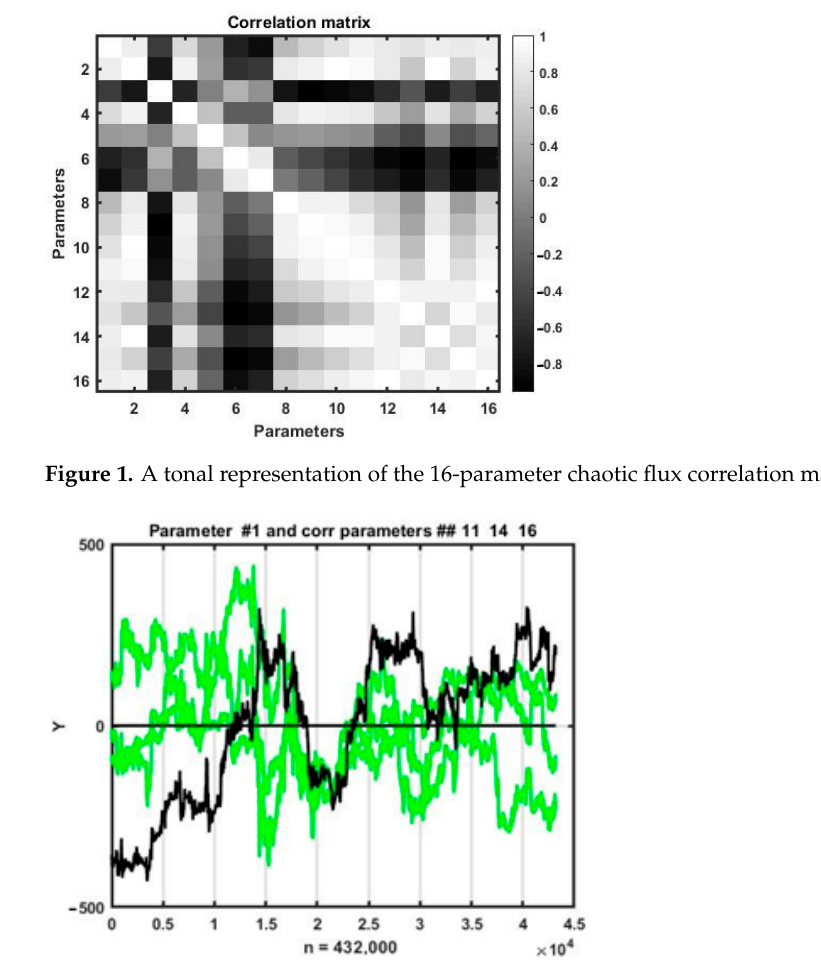
Figure 2. Simultaneous changes in the forecasted parameter (No. 1) and its three most correlated parameters (No. 11, 14, and 16).